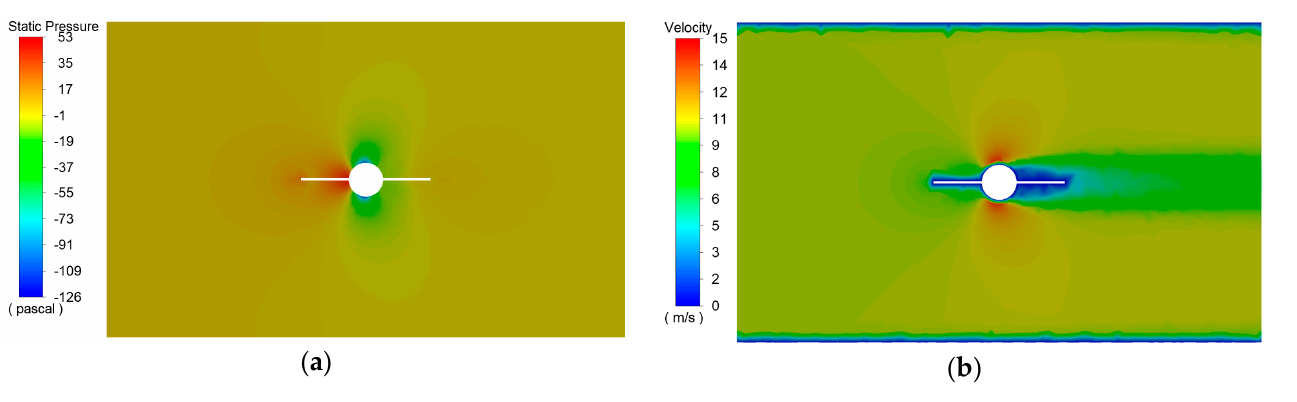
Figure 9. ( a ) Pressure distribution; ( b ) Velocity distribution for the tube with 2 fins (case c1).